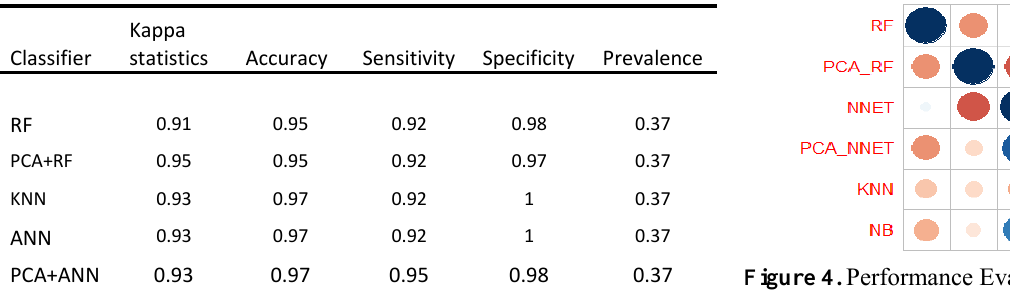
Table 3. Performance for the proposed system (Accuracy)